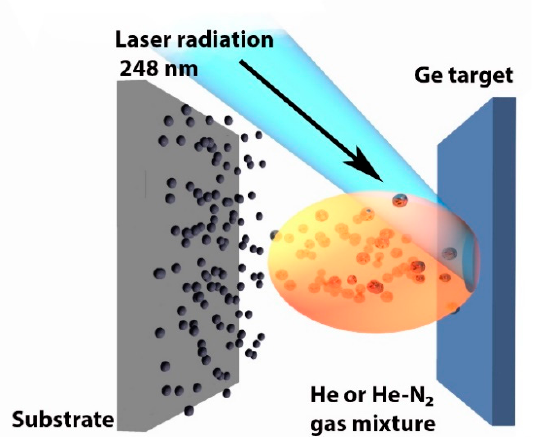
Figure 1. Experimental setup. A rotated Ge target is irradiated by a focused beam from UV excimer laser at the angle of 45 ◦ to initiate ablation of Ge nanoclusters in residual gases (He or He-N 2 mixtures). The nanoclusters are deposited on a substrate located 2 cm from the target surface.